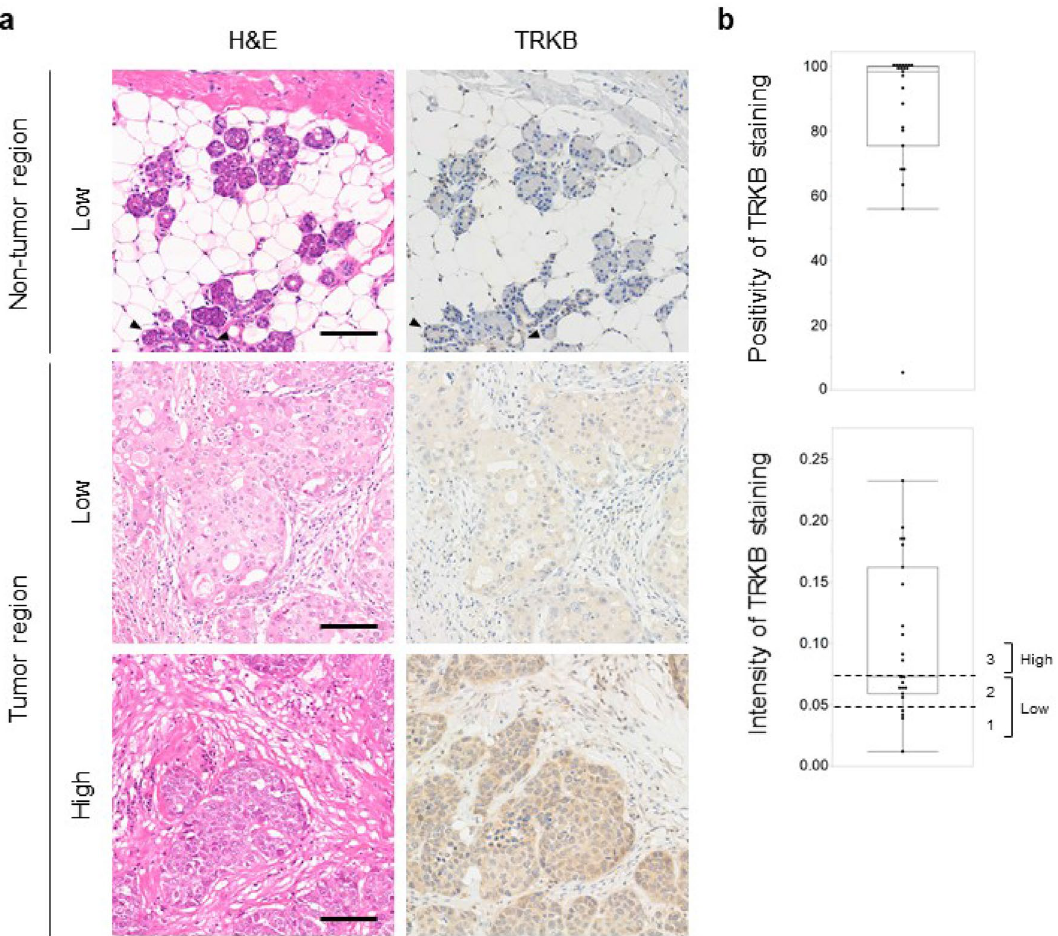
Figure 5. High expression of TRKB in PGCs. (a) Representative H&E and TRKB staining images of tumor tissues from patients with PGC. Arrowheads indicate ductal epithelial cells with faint expression of TRKB. Scale bars, 100 μm. ( b) TRKB expression levels in each type of PGC. Positivity and intensity of TRKB staining in cancer cells were analyzed using inForm and Spotfire software. TRKB expression levels were classified into three levels (staining intensity: < 0.05, level 1; 0.05–0.75, level 2; > 0.75, level 3) and divided into two groups: low (levels 1 and 2) and high (level